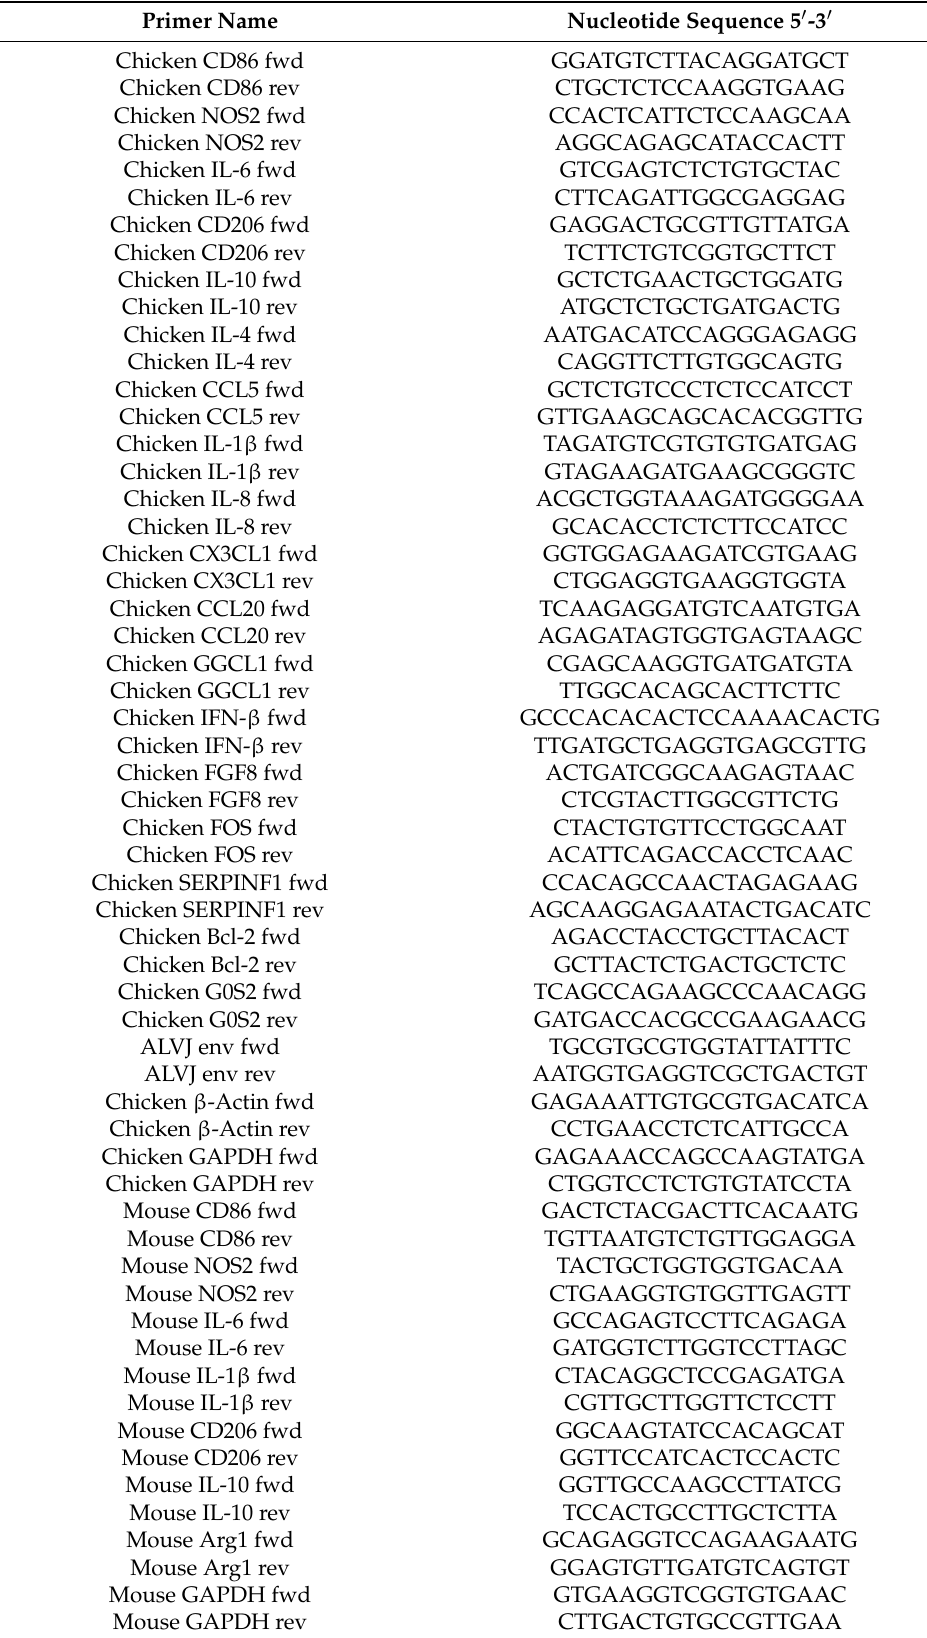
Table 1. Primers used in this